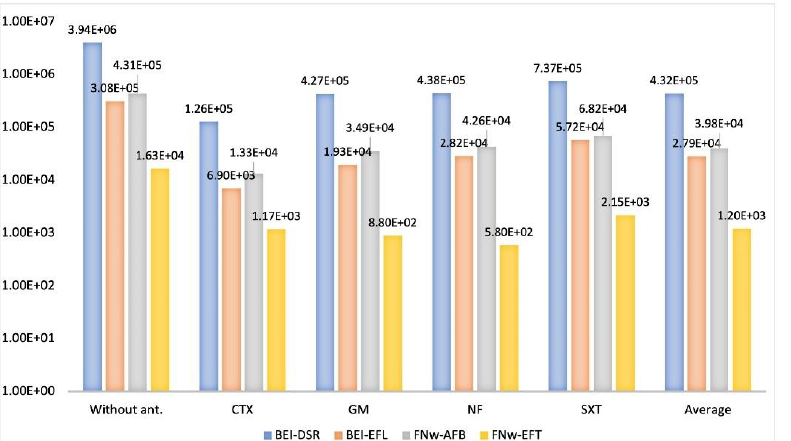
Figure 2. The number of colony-forming units that grew on Drigalsky without antibiotics (without ant.) and supplemented with the antibiotics: cefotaxime (CTX), gentamicin (GM), norfloxacin (NF), and trimethoprim-sulfamethoxazole (SXT). BEI-DSR: Beirolas-Lisboa influent wastewater; BEI-EFL: Beirolas-Lisboa effluent wastewater; FNw-AFB: Faro Northwest-Algarve influent wastewater; FNw-EFT: Faro Northwest-Algarve effluent wastewater.